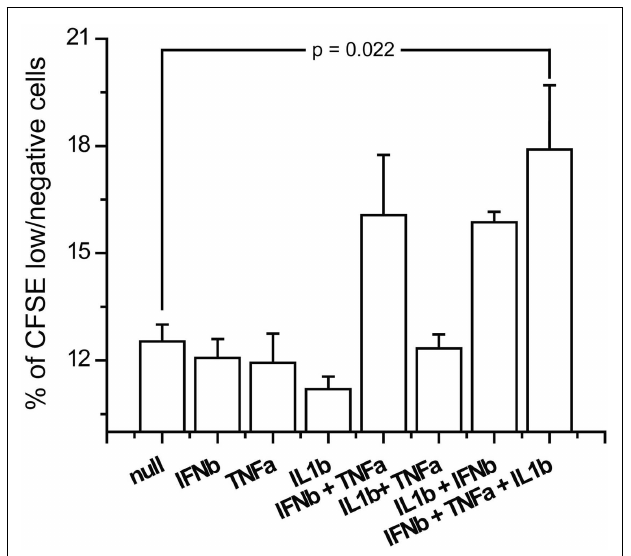
FIGURE 10 |Antigen specific proliferation ofT-cells exposed to cytokine pretreated DCs . Measles antilogous specificT-cells were co-cultured with cytokine pretreated DCs which were also pulsed with measles vaccine. Proliferation was measured by the dilution of CFSE.